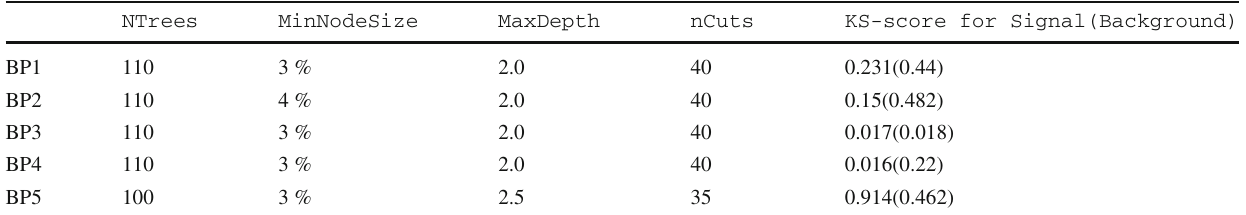
Table 11 Tuned BDT parameters for BP1, BP2, BP3, BP4 and BP5 for the channel 2 (cid:3) + E T /